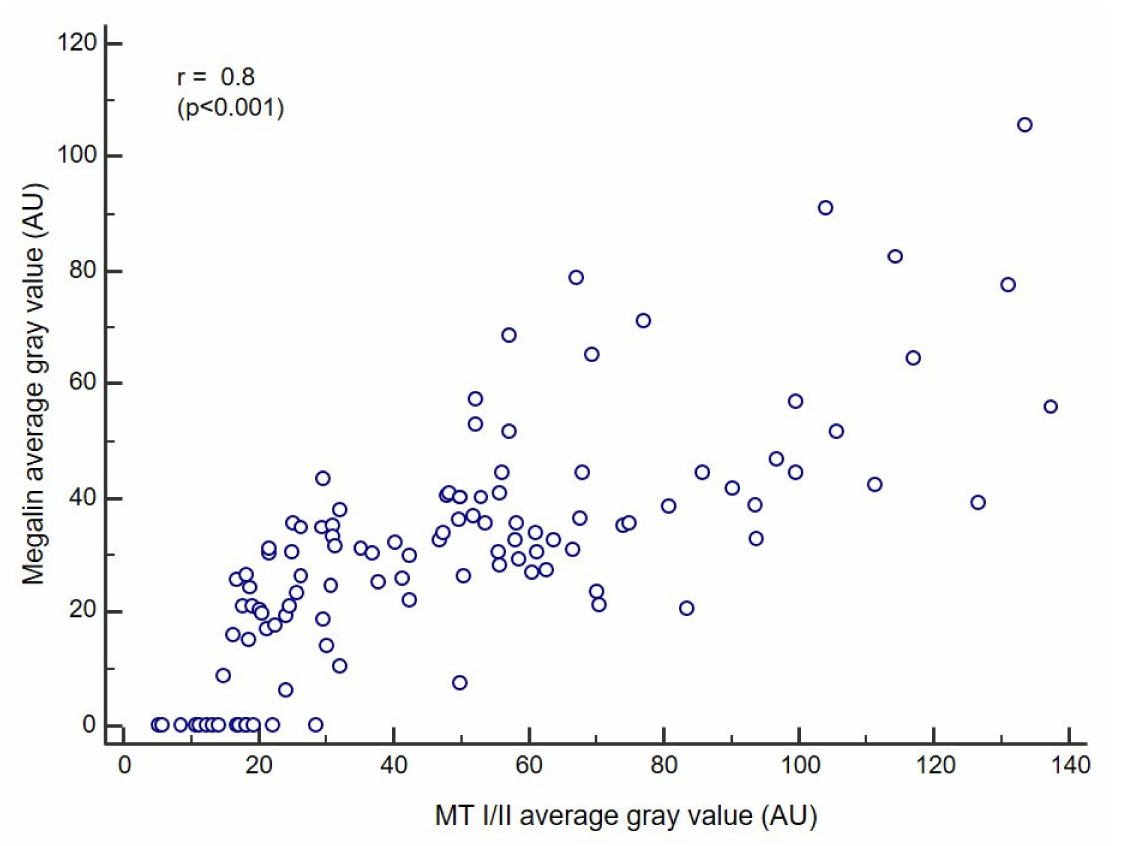
Figure 6. Correlation of metallothionein I/II and megalin staining intensities. Pearson correlation analysis included data obtained from the overall study group. Correlation coefficient (r) = 0.8 ( p < 0.001).